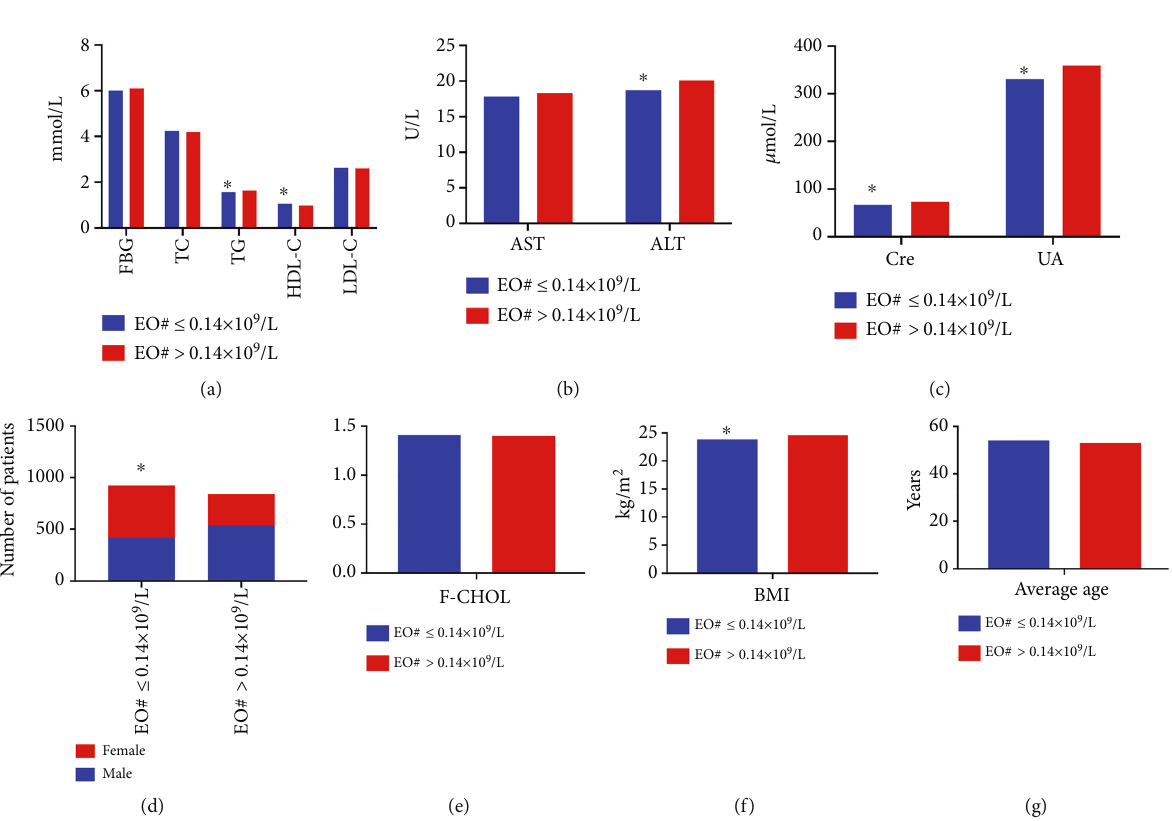
Figure 3: Comparison of di ff erent indicators between the EO# ≤ 0 : 14 × 10 9 /L and EO#>0 : 14 × 10 9 /L groups. (a) Comparison of levels of FBG, TC, TG, HDL-C, and LDL-C between the two groups. Compared with the EO#>0 : 14 × 10 9 /L group, the levels of TG were signi fi cantly lower and HDL-C was higher in EO# ≤ 0 : 14 × 10 9 /L group. (b) Comparison of AST and ALT levels between the groups. The levels of ALT were signi fi cantly lower in EO# ≤ 0 : 14 × 10 9 /L group than in the EO#>0 : 14 × 10 9 /L group.(c) The levels of Cre and UA in EO# ≤ 0 : 14 × 10 9 /L group were signi fi cantly lower than that in EO#>0 : 14 × 10 9 /L group. (d) Comparison of the number of male and female patients between the groups. (e) Comparison of levels of F-CHOL between the groups. (f) The BMI of patients in WBC ≤ 4 × 10 9 / L group was signi fi cantly lower than that in WBC > 4 × 10 9 /L group. (g) Comparison of the average age of patients between the two